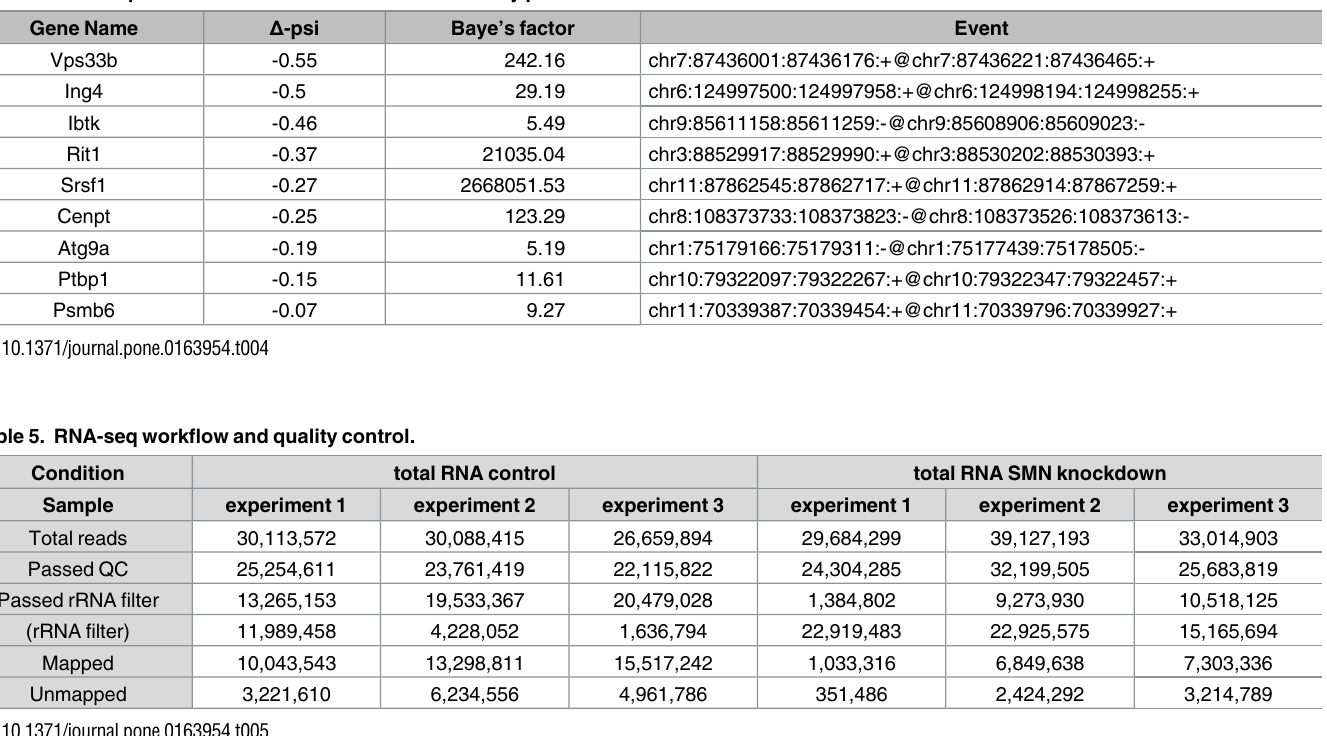
Table 4. SMN-dependent intron retention events ranked by percent